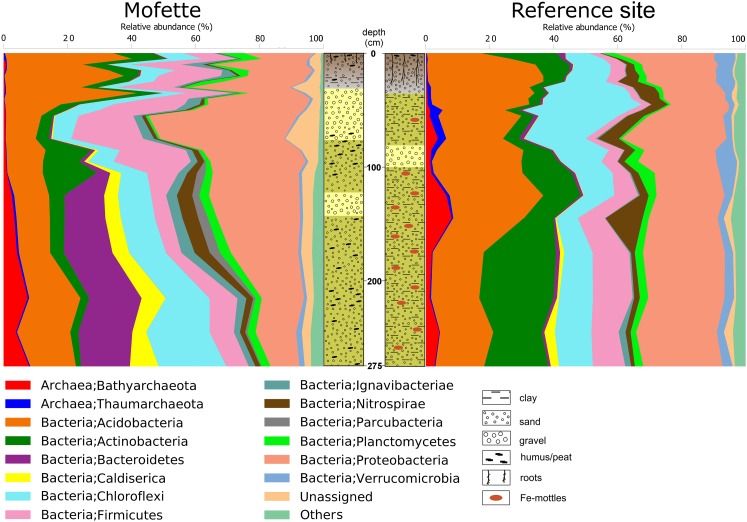
Community structures at phylum level (most abundant 14 phyla) and the lithological profiles of the cores.